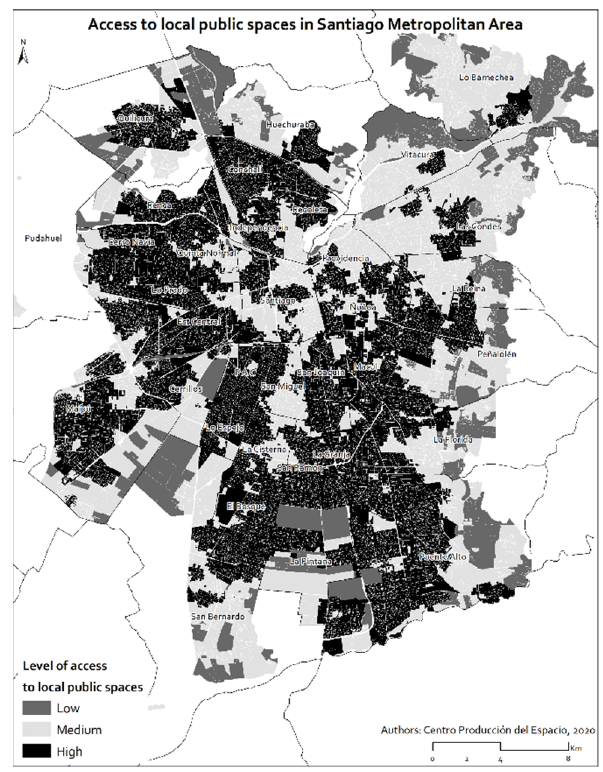
Figure 3. Access to Public Spaces in the Santiago Metropolitan Area. Source: authors.